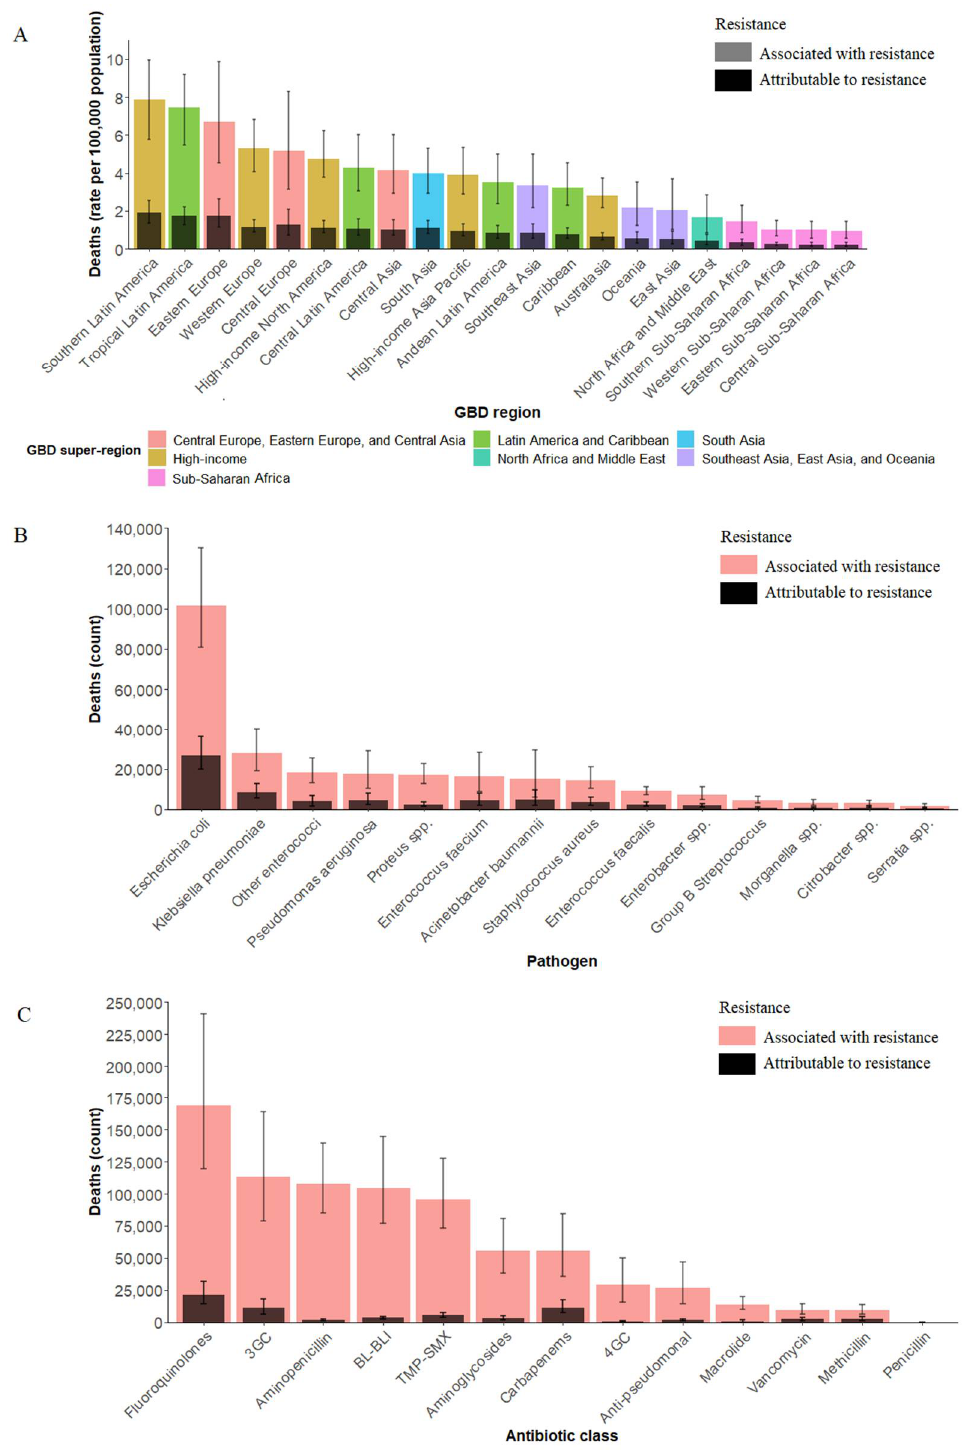
Figure 1. All-age rate of deaths among 21 GBD regions. ( A ) All-age count of deaths among 14 pathogens and ( B ) all-age count of deaths among 13 antibiotic classes ( C ) attributable to and associated with bacterial AMR, 2019. AMR = antimicrobial resistance. GBD = Global Burden of Diseases, Injuries, and Risk Factors Study. 3GC = third-generation cephalosporins. 4GC = fourth-generation cephalosporins. Anti-pseudomonal = anti-pseudomonal penicillin or beta-lactamase inhibitors. BL-BLI = β-lactam or β-lactamase inhibitors. Resistance to 1+ = resistance to one or more drugs. TMP-SMX = trimethoprim/sulfamethoxazole. AMR = antimicrobial resistance. Error bars indicate 95% uncertainty intervals.